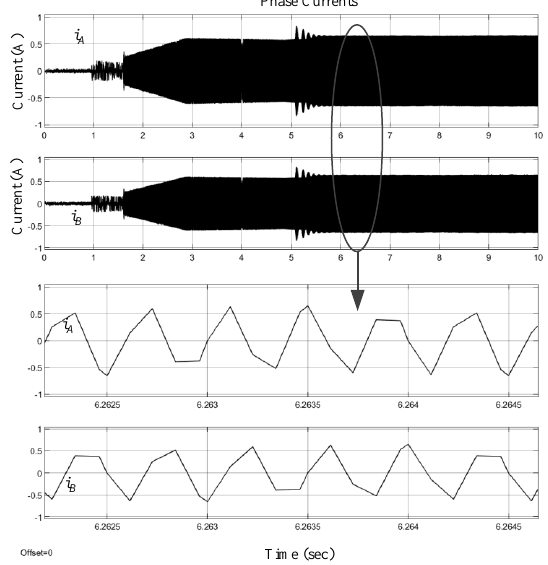
Figure 12. The simulated stator current responses for the speed command of 314 rad/s.